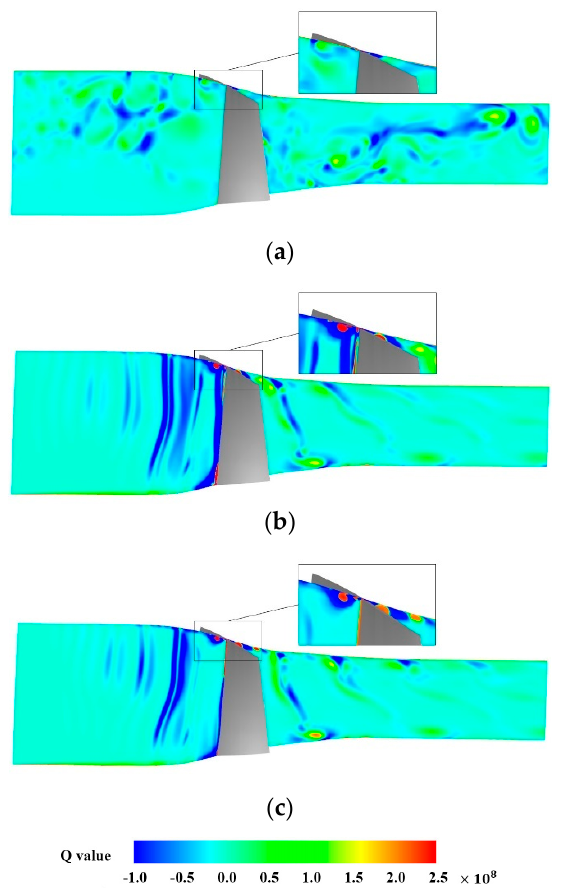
Figure 7. Q value contours on the meridian plane of the NASA rotor 37 at ( a ) NS condition, ( b ) design condition, ( c ) NC condition.